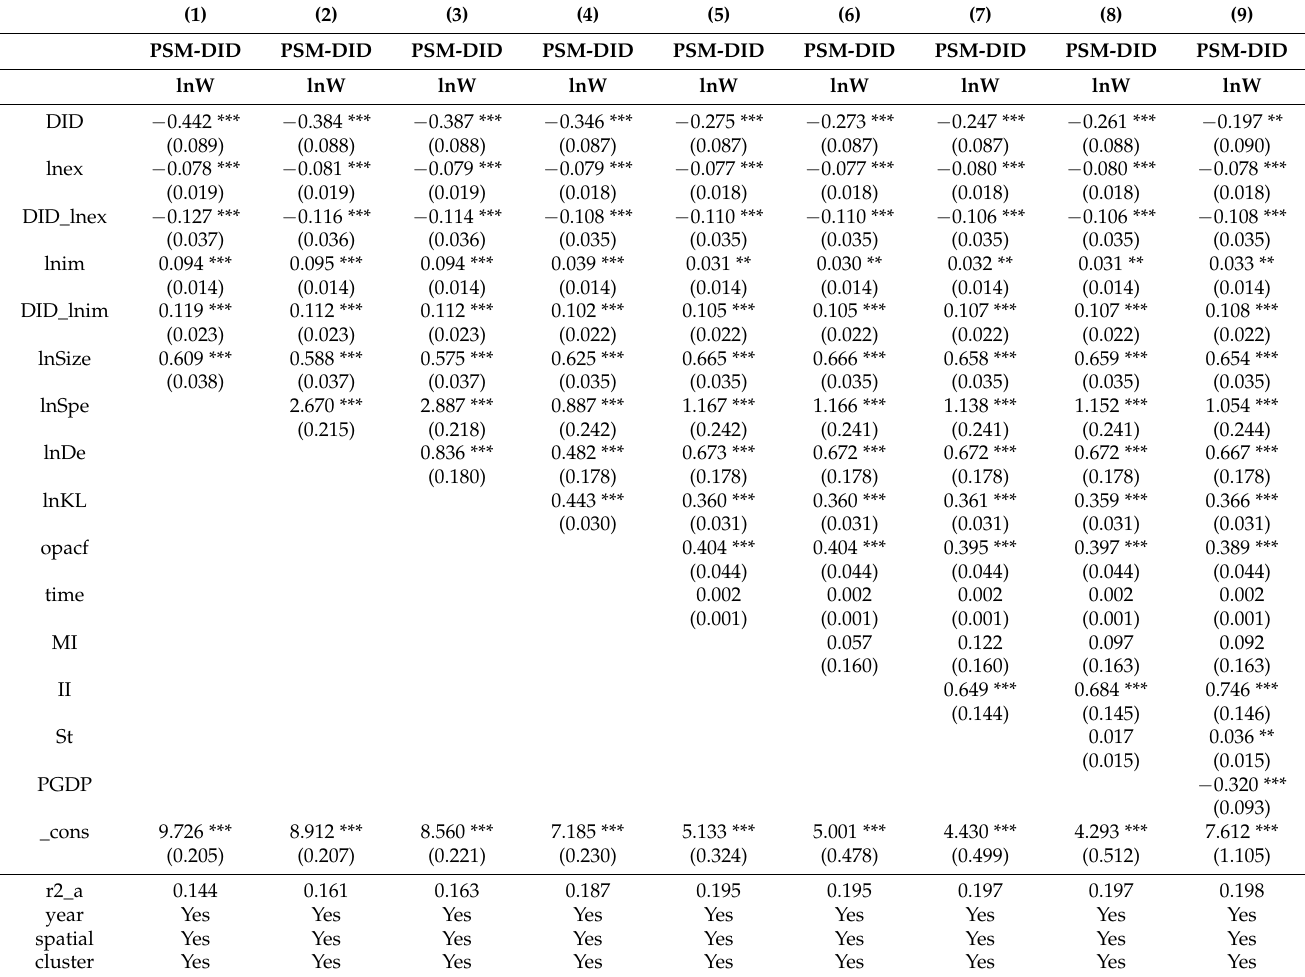
Table 2. Benchmark regression